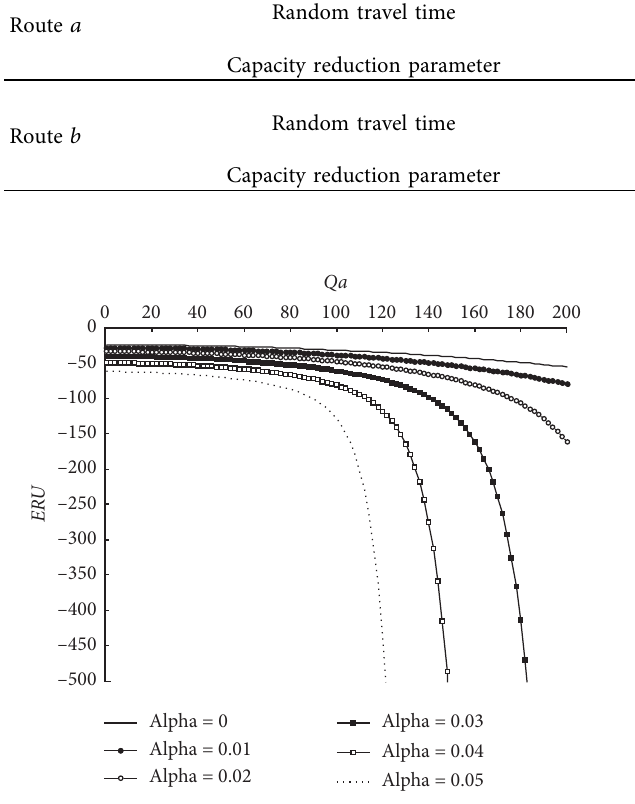
Figure 6: Expected regret-based utility of route a based on different regret aversion scenarios.